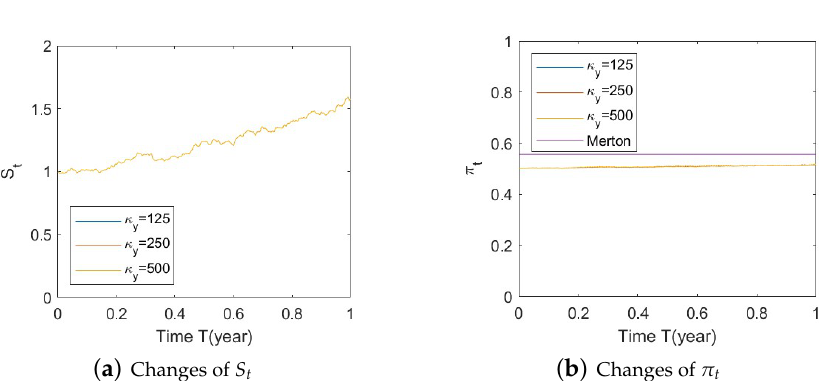
Figure A28. Illustrate the impact on ( a ) stock prices and ( b ) optimal stock allocations when varying the speed of reversion, κ y ( e . g ., κ y = 125,250,500 ) .